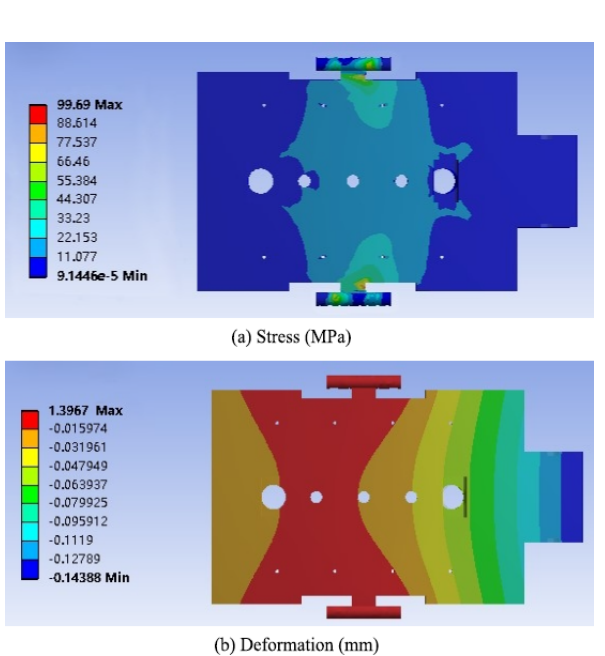
Figure 6. The cloud diagrams of the stress and deformation of the front frame.